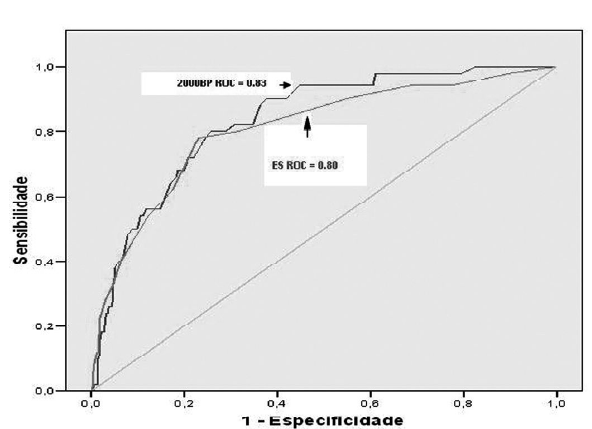
Fig. 1 - Curva ROC - *2000BP ROC= Curva ROC dada pelo escore 2000 Bernstein Parsonnet; ES ROC= Curva ROC dada pelo